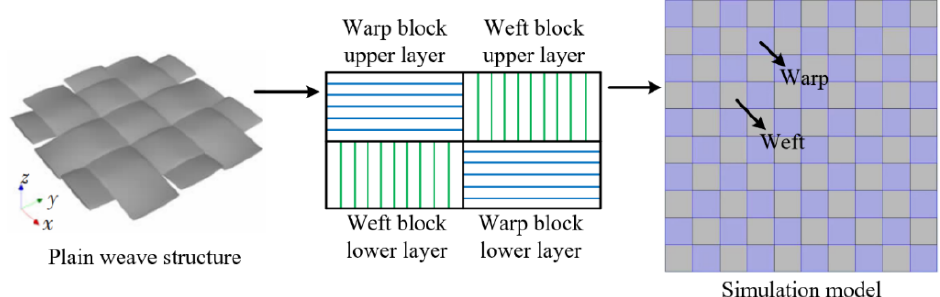
Figure 4. Quartz fiber discretization simulation model.